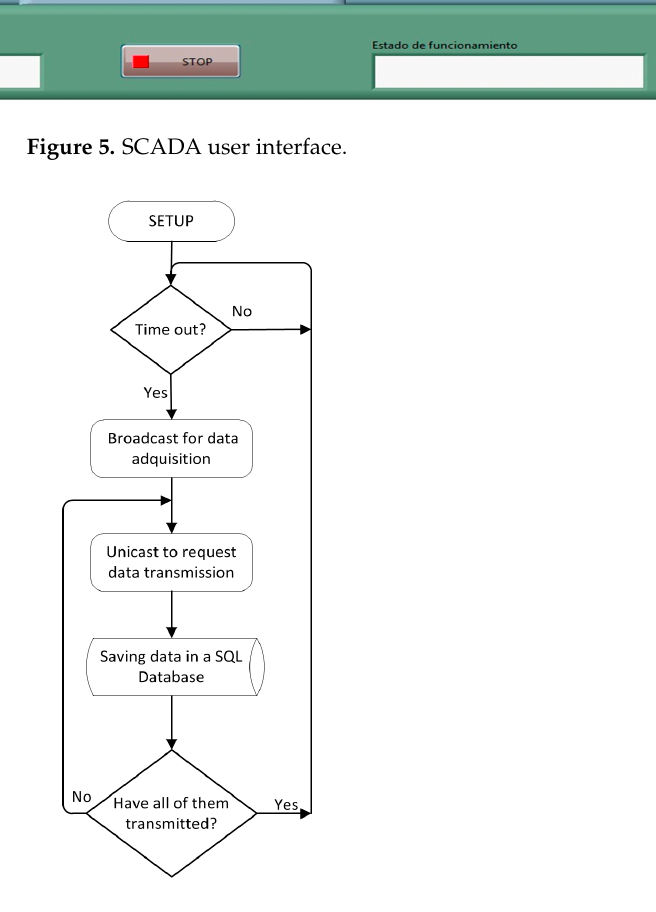
Figure 6. SCADA flowchart.